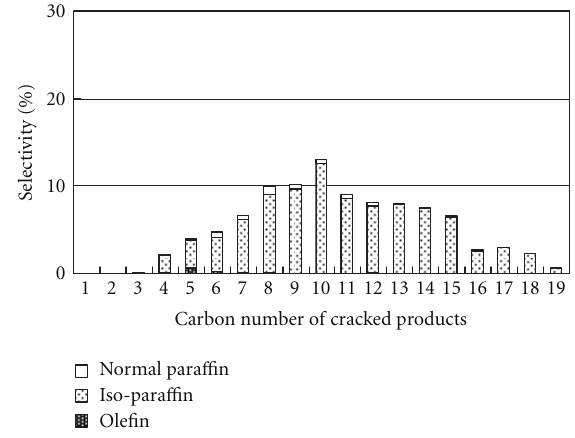
Figure 13: Reaction scheme of catalytic cracking of hydrotreated oil over ns Al 2 O 3 /USY and ns Al 2 O 3 /H-GaAlMFI zeolite catalyst based on Figures 8 and 12.